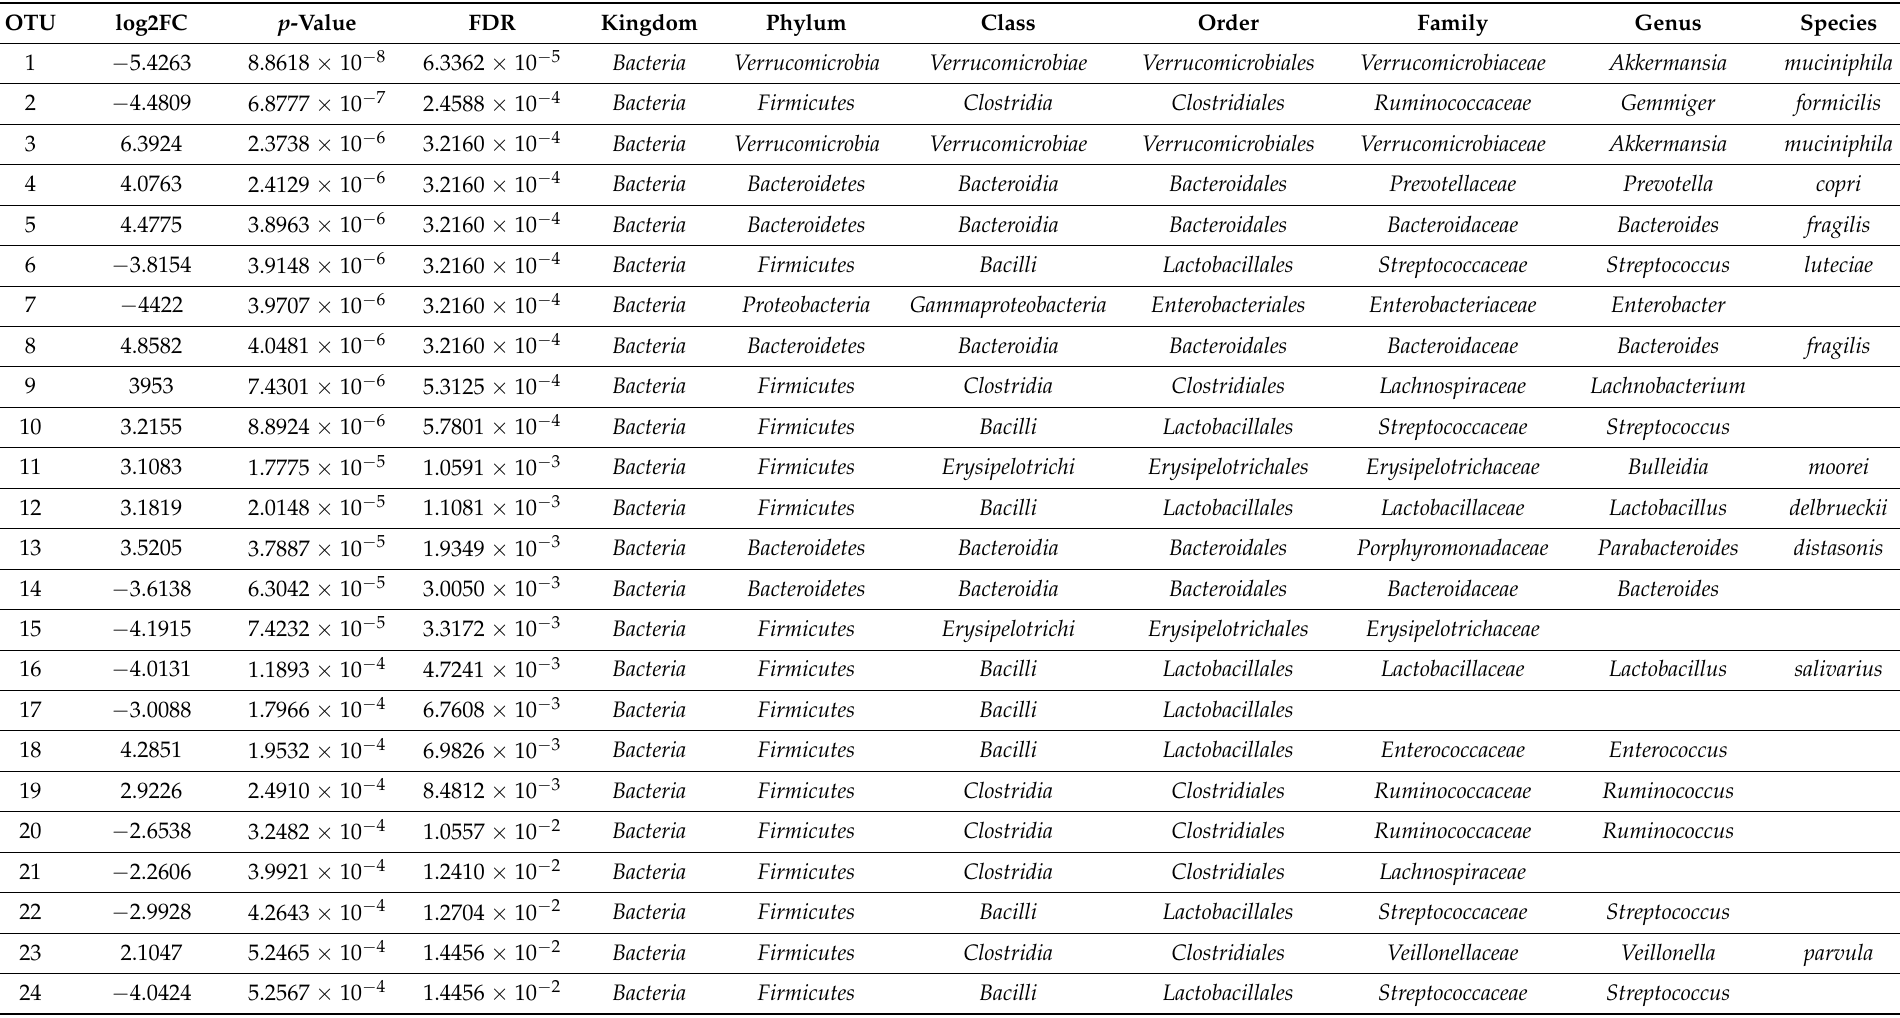
Table 4. Changes in the Operational Taxonomic Units (OTUs) induced by the two-phase diet with respect to the baseline and the relative taxonomic classification. log2FC (fold change). FDR: False Discovery